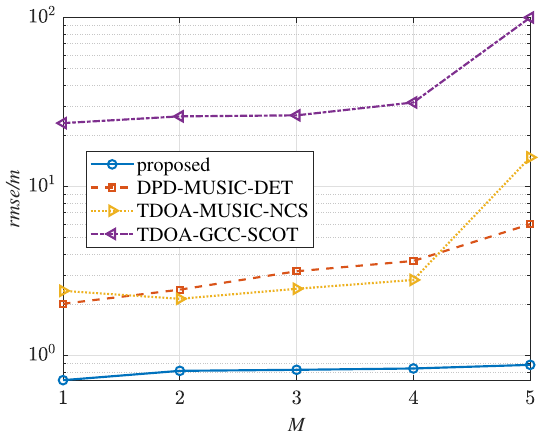
Figure 7. RMSE curves versus the number of multipath components ( snr = − 3